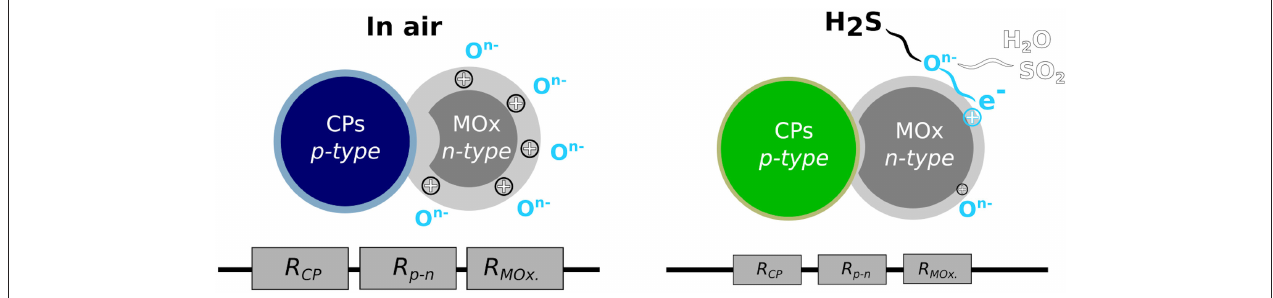
FIGURE 3 | Mechanisms of H 2 S detection by CPs hybridized with metal oxide (MOx). R CP , R MOx , and R p − n represent the resistance contribution of the polymer, the MOx, and the depletion layer at the interface between the two materials (p–n junction), respectively. The depletion layer is represented by lighter colors. The size of the resistance represents their tendency to decrease in contact with H 2